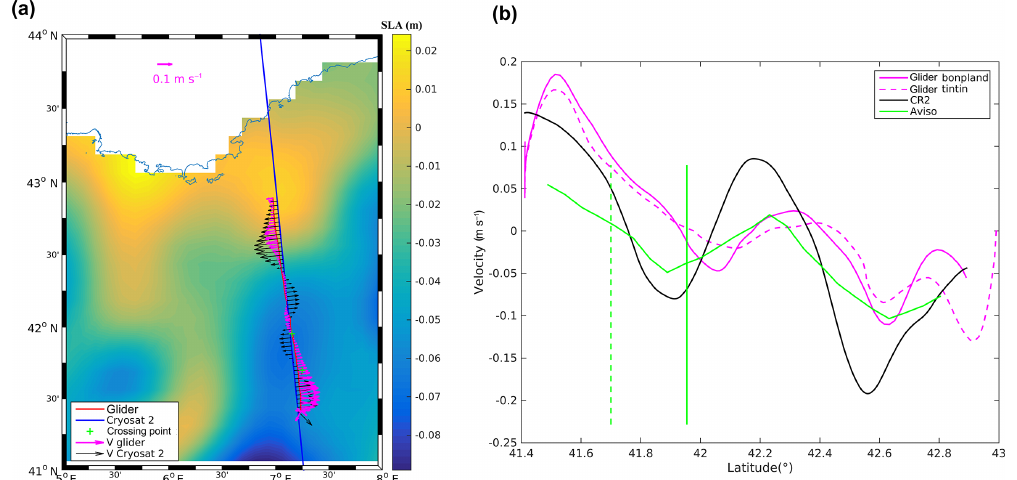
Figure 9. (a) Co-located CryoSat-2 track 493 currents (in black) and glider currents (in pink), overlaid with a satellite SST plot on 27 April 2015. Two gliders, Bonplan-d and Tintin, follow at 1-day intervals. (b) Along-track comparison of geostrophic velocities for the Bonplan-b glider (pink solid), and Tintin (pink dashed) with the filtered CryoSat-2 SAR data in black. Mapped AVISO altimeter data, inter- polated back onto the altimeter track, are in green. Green vertical line shows the position when the altimeter data and gliders are co-located. (solid for Bonplan-d; dashed for Tintin). Daily SST fields at 0.02 ◦ resolution from